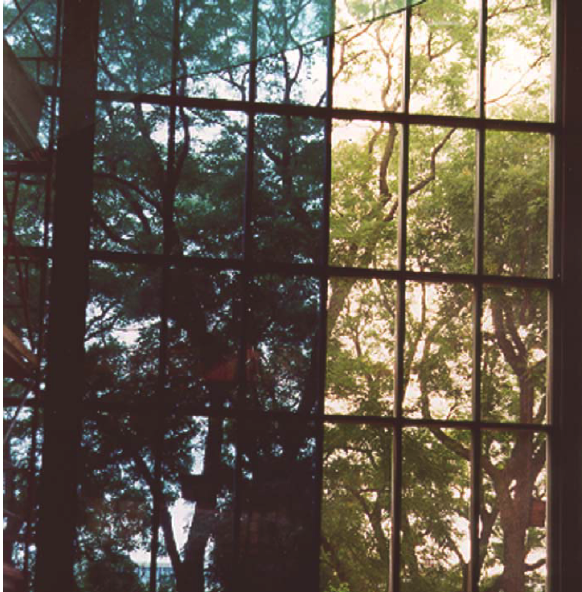
Fig. 10. An electrochromic window with the left side switched to near-IR and glare blocking mode, and the right side clear. This win- dow was produced by Flabeg and reported by Lampert [47]. Permit- ted under creative commons license, http://creativecommons.org/